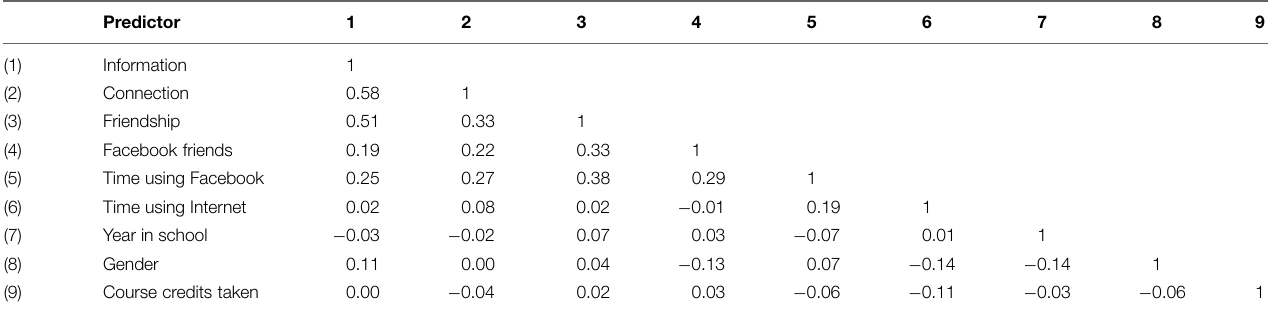
TABLE 3 | Zero-order correlations among variables predicting psychological well-being.